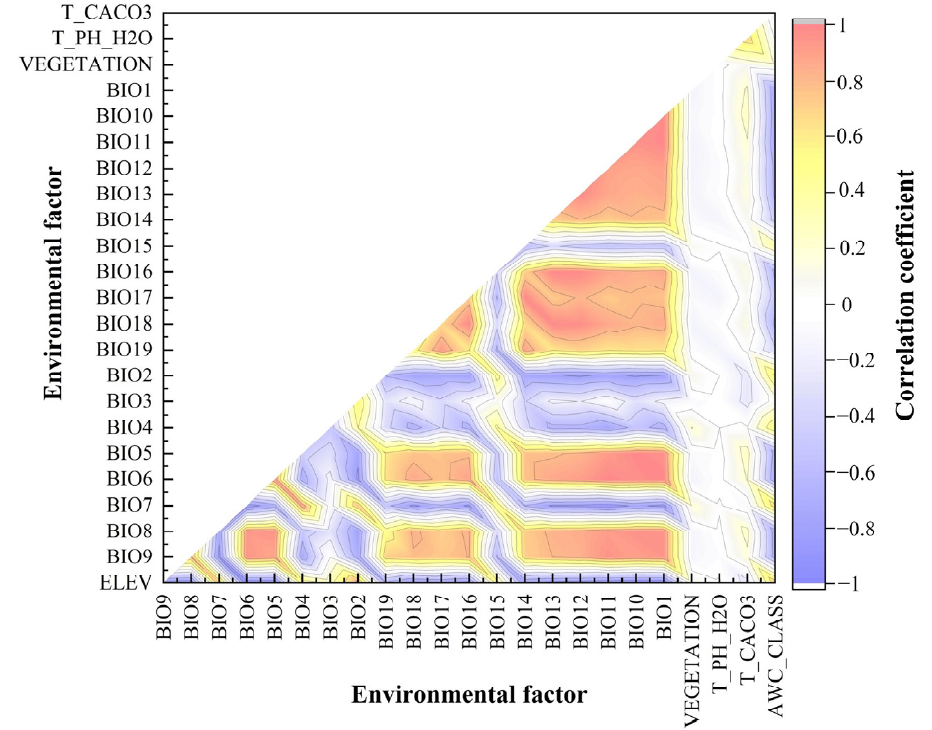
Figure 1. Matrix of environmental factor correlation coefficients.